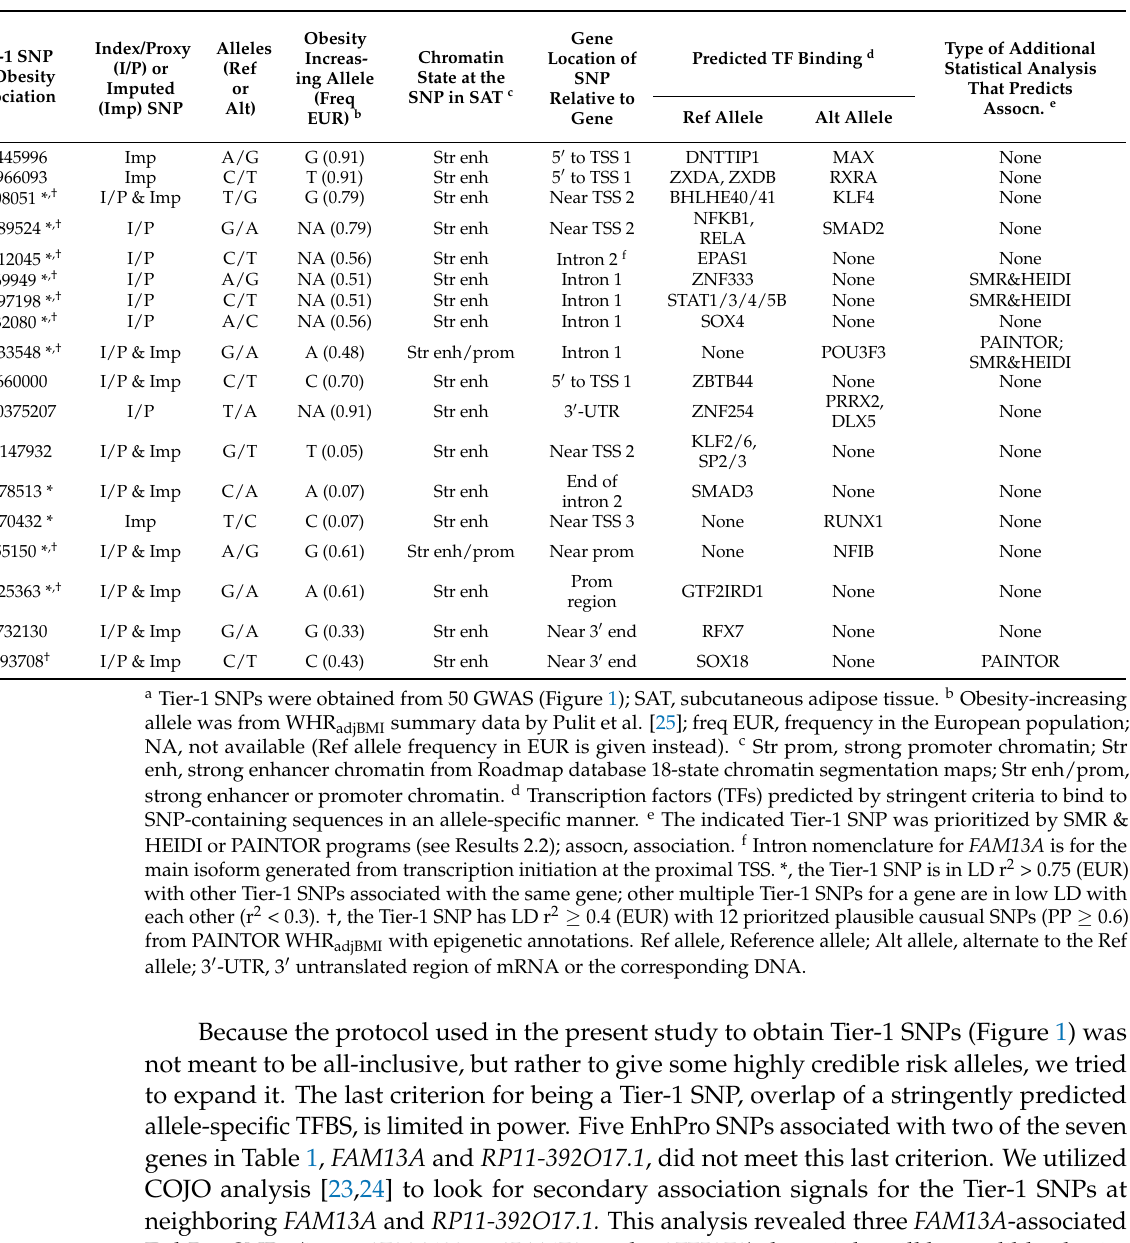
Table 1. Eighteen prioritized candidates for regulatory obesity-risk variants (Tier-1 SNPs) associated with seven SAT-related genes a